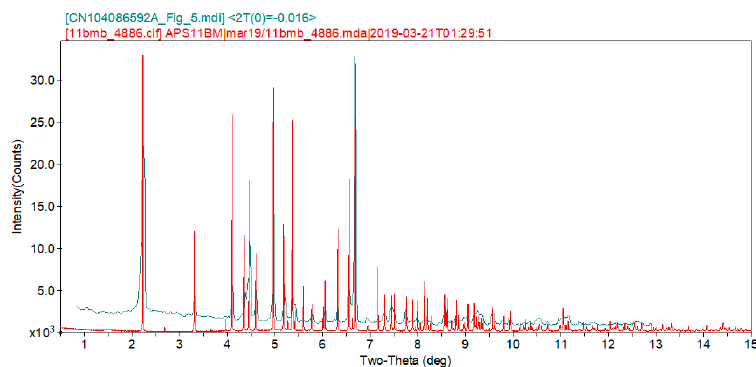
Figure 2. Comparison of the synchrotron pattern (red) of fosfomycin tromethamine with the laboratory diffraction pattern from Huang et al. [1]. The literature pattern (measured using Cu K α radiation) was digitized using UN-SCAN-IT [4] and scaled to the synchrotron wavelength of 0.412826 Å using Jade 9.8 [5].